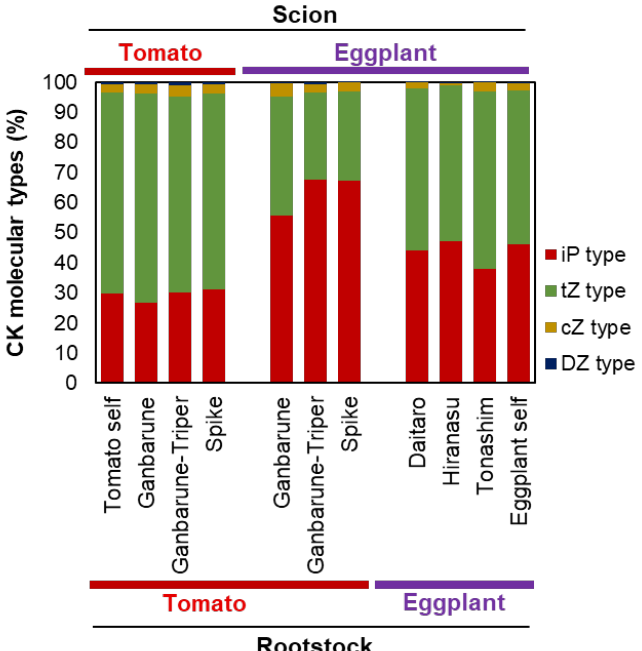
Figure 5. The percentage of CK molecular types in the xylem exudates of various grafting combina- tions. The concentrations of N 6-( ∆ 2-isopentenyl)-adenine type (iP-type), trans-zeatin type (tZ-type), cis-zeatin type (cZ-type), and dihydrozeatin type (DZ-type) CKs in the xylem exudates of various grafting combinations. Red, green, yellow, and blue indicate iP type, tZ type, cZ type, and DZ type CKs, respectively. Tomato self indicates ‘CF Momotaro Haruka’ grafted onto the ‘CF Momotaro Haruka’ plant, and the eggplant self indicates ‘Shikibu’ grafted onto the ‘Shikibu’ plant. Values are the means of four replicate samples.